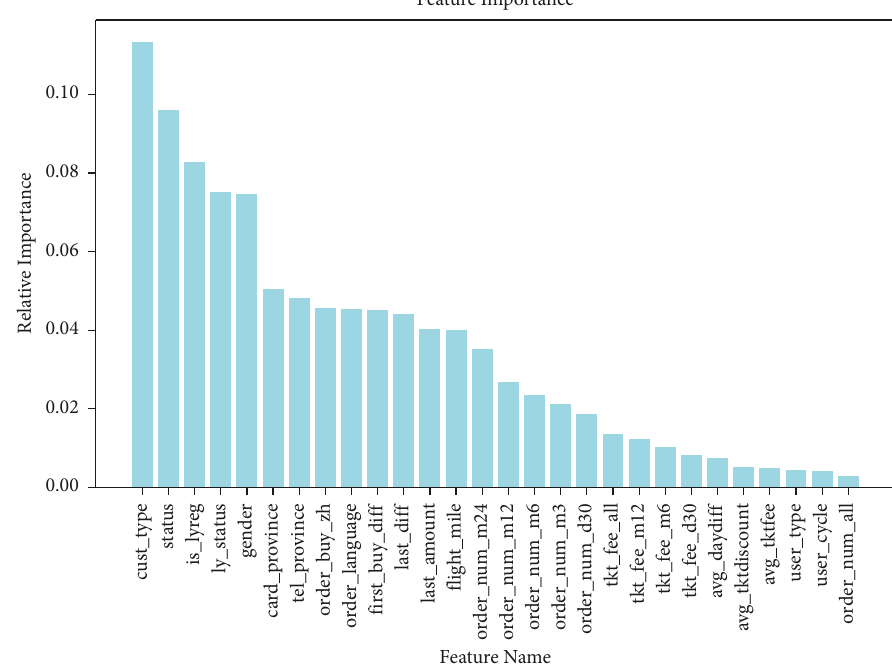
Figure 2: The importance of features. Table 2: (70–30%) of data: models’